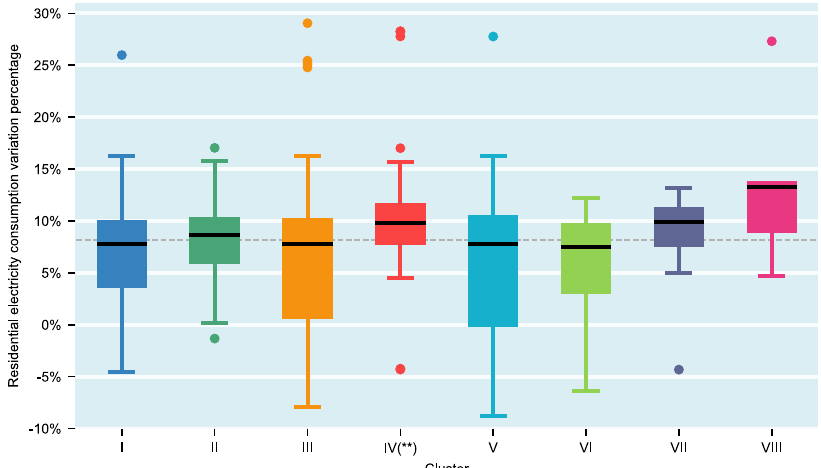
Fig. 5 | ResidentialECvariation among different clusters. Box and whisker plots of residentialECvariation ofApril – May 2020 in comparison to pre-pandemiclevel in April – May 2019; boxes depict the upper and lower quartiles of the data; black solid lines depict the median values; whiskers depict the range of the data excluding outliers (outliers are de fi ned as observations larger than 1.5× the inter- quartile range from the upper or lower quartiles); the grey dashed line depicts the medianvalueoftheresidentialECvariationof380MSAs.Two-sidedWilcoxonrank